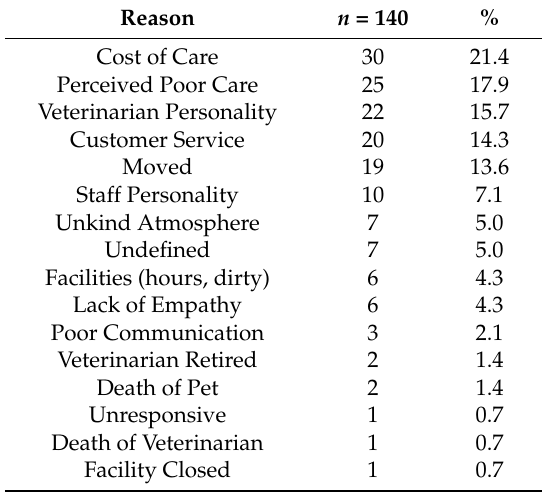
Table 1. Pet owner reasons for not returning to veterinary